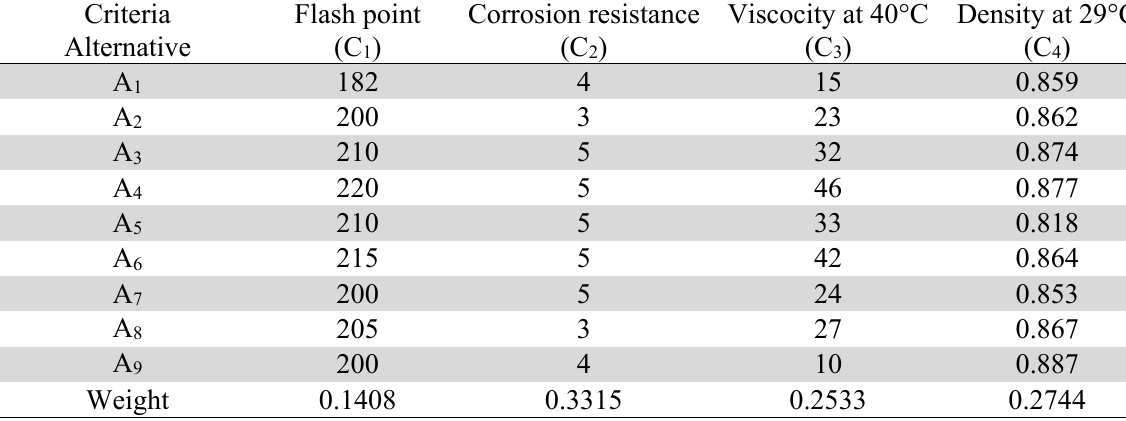
Decision matrix for soluble oil selection